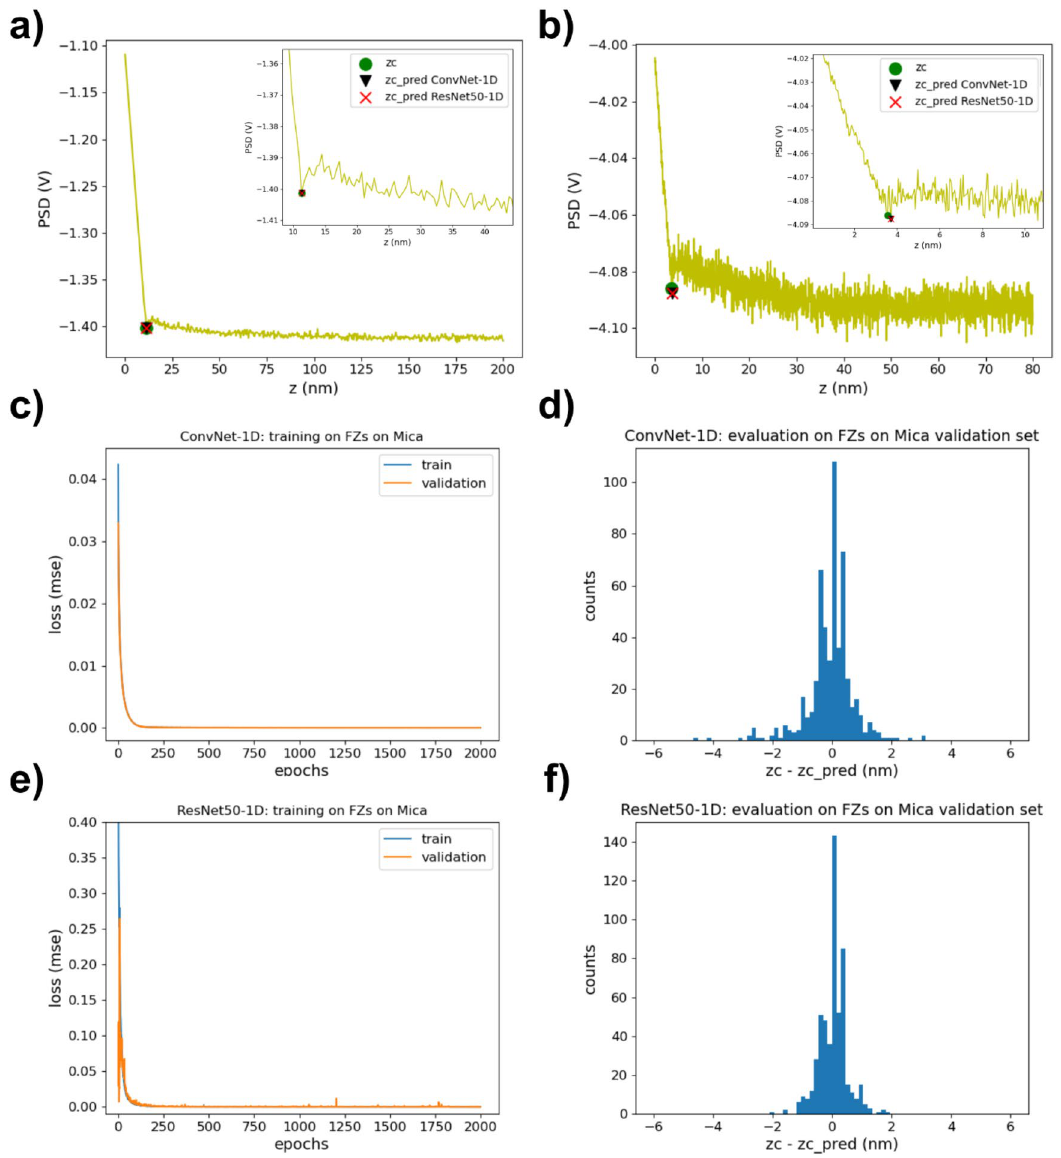
Figure 2. (a ) and ( b ) Representative examples of force curves obtained with Si 3 N 4 AFM tips on mica surfaces in NaCl aqueous solutions. The insets correspond to zooms of the contact point region. The curves also contain markers for the labelled contact point (green circle) as well as the contact points predicted by ConvNet-1D (black triangle) and by ResNet50-1D (red cross). ( c ) Evolution of the mse loss function i.e., the mean squared differences between labelled and ConvNet-1D predicted normalized sample positions corresponding to the contact point, obtained while training ConvNet-1D on force curves on mica. Loss values for both the training and validation sets are shown. Total training time = 1096 s (~ 0.55 s/epoch). ( d ) Distribution of the difference between the sample positions of the hand-labelled, zc, and the ConvNet-1D predicted, zc_pred, contact